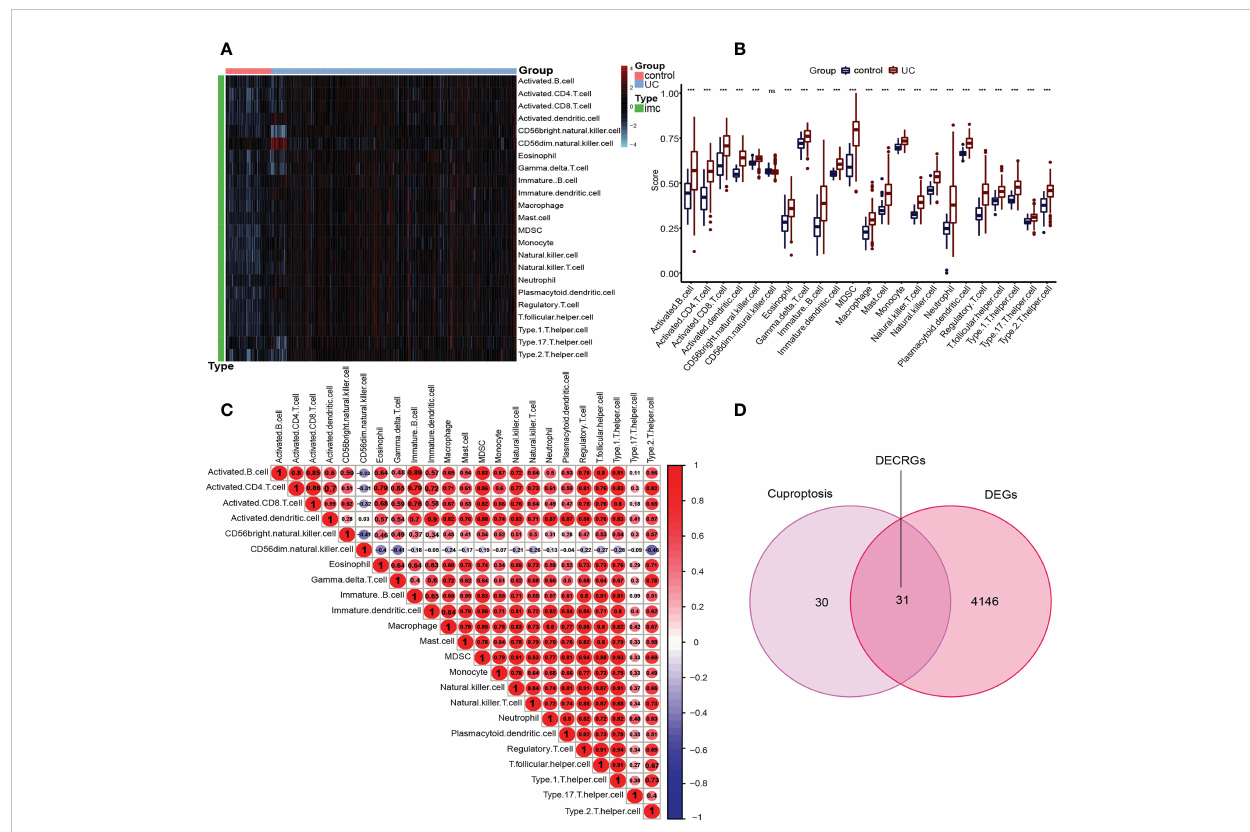
FIGURE 3 Immune in fi ltration in UC patients and controls and identi fi cation of DECRGs. (A) Each row of the heat map represents a type of immune cell, and each column represents one sample, either UC or normal. (B) Box plots depicting the in fi ltration levels of immune cells in UC and control groups. ***p < 0.001. ns, no signi fi cance. (C) Correlation heatmap depicting the correlations between distinct immune cell compositions. Red dots represent positive correlation, blue dots represent negative correlation, and the higher the absolute value of the number in the dot, the greater the correlation. (D) Venn diagram showing the DECRGs shared by DEGs and cuproptosis-related